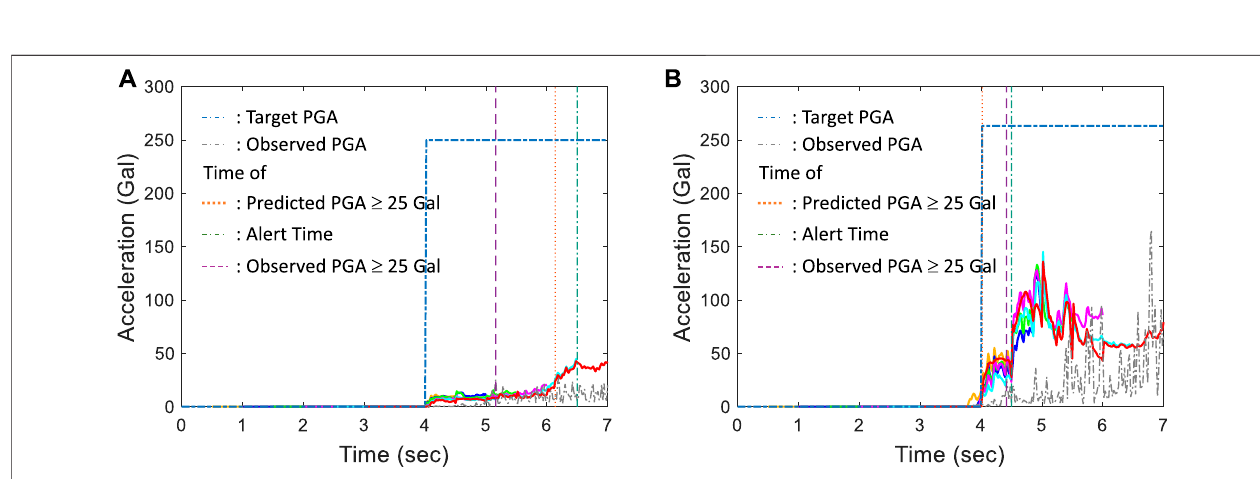
FIGURE15| ObservedPGAtimehistories,predictedPGAtimehistoriesofdifferentwindows,andtargetPGAtimehistoriesof (A) theonlycaseofleadtime < − 1 s in the Meinong data set, and (B) a typical case of lead time < 0 s in the independent data sets.